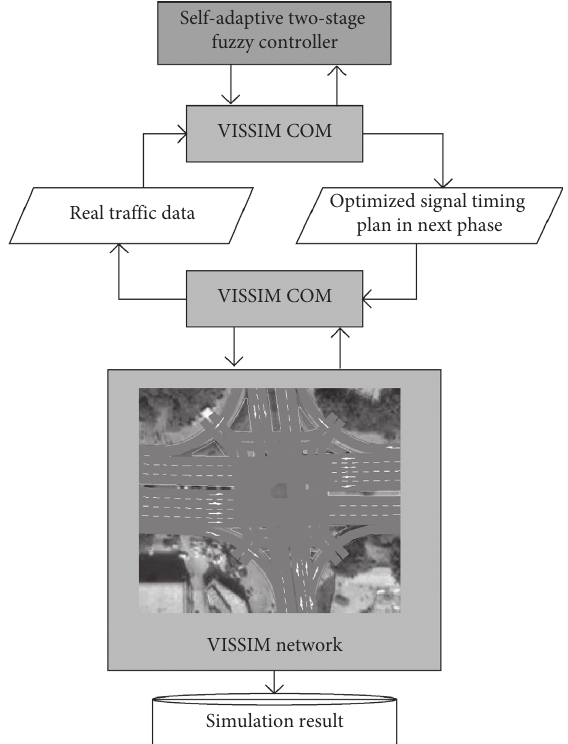
Figure 4: The structure of the VISSIM simulation